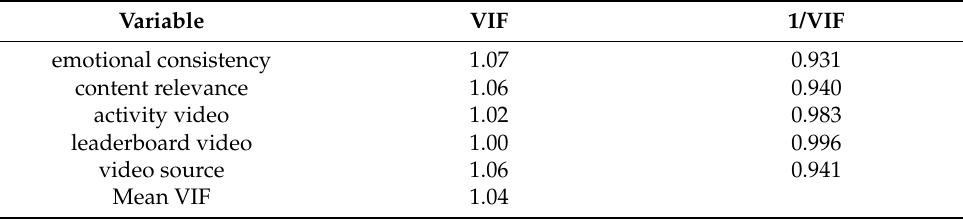
Table 4. Independent variable variance inflation factor.